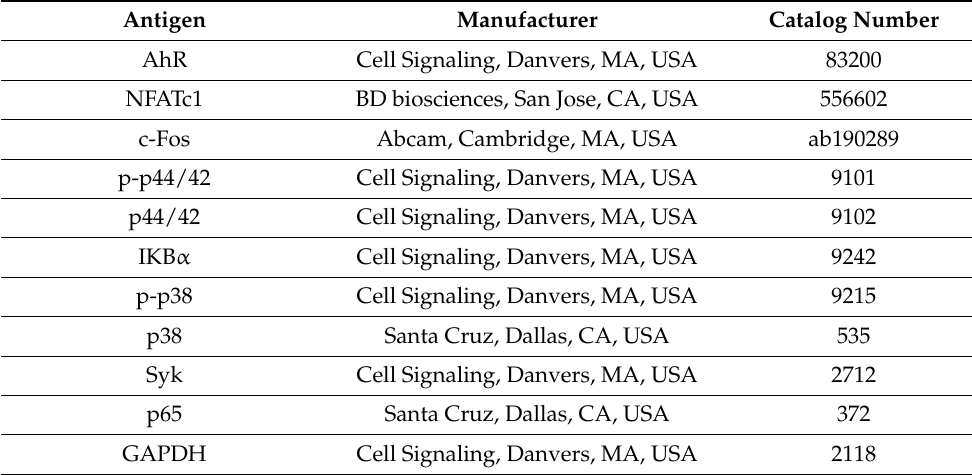
Table 2. Primary antibodies used in